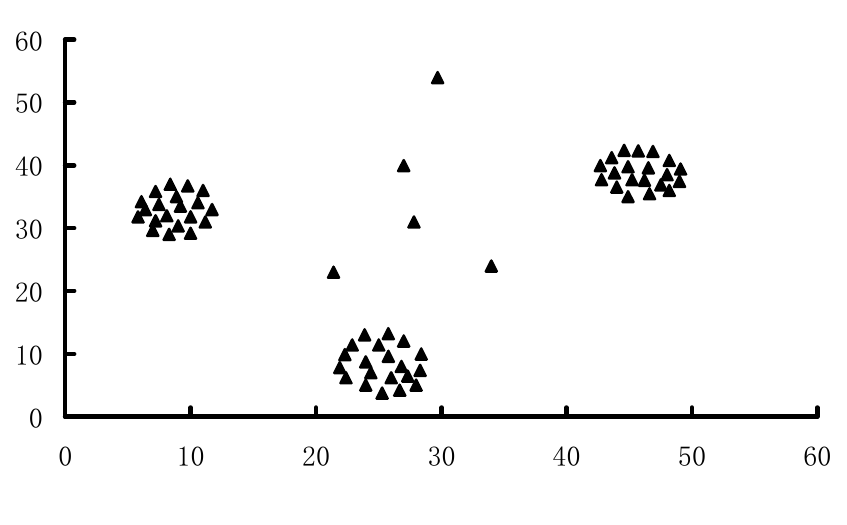
Figure 5: Synthetic